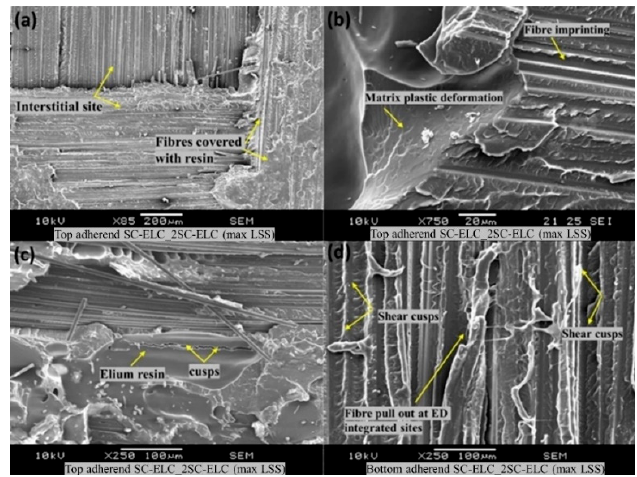
Figure 22. SEM fractography of 2SC-ELC_SC-ELC for maximum LSS ( a–c ) represents the failure image of the top adherends showing fibre imprinting, shear cusps and matrix plastic deformation ( d ) represents the failure image of the bottom adherend showing shear cusps and fibre pull at ED sites.